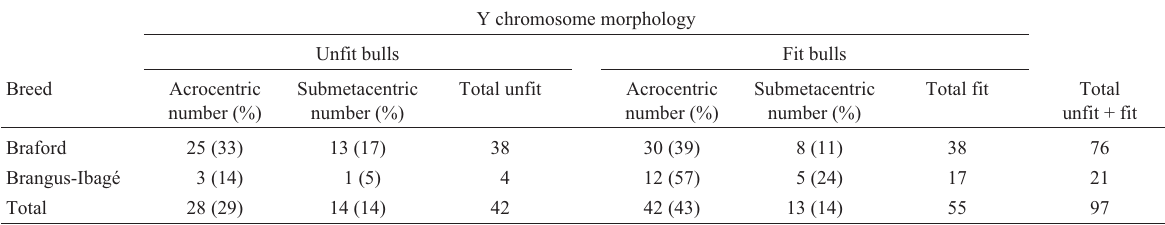
Table 2 - Cytogenetically determined frequency of the different types of Y chromosomes in Braford and Brangus-Ibagé bulls which had been classified by breeding soundness evaluation. Y chromosome morphology